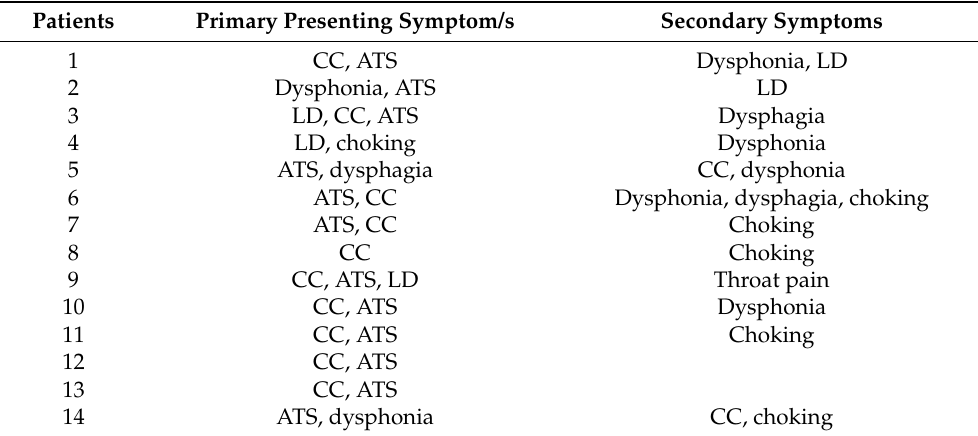
Table 5. Clinical characteristics. CC, chronic cough; ATS, abnormal throat sensation; LD, laryngeal